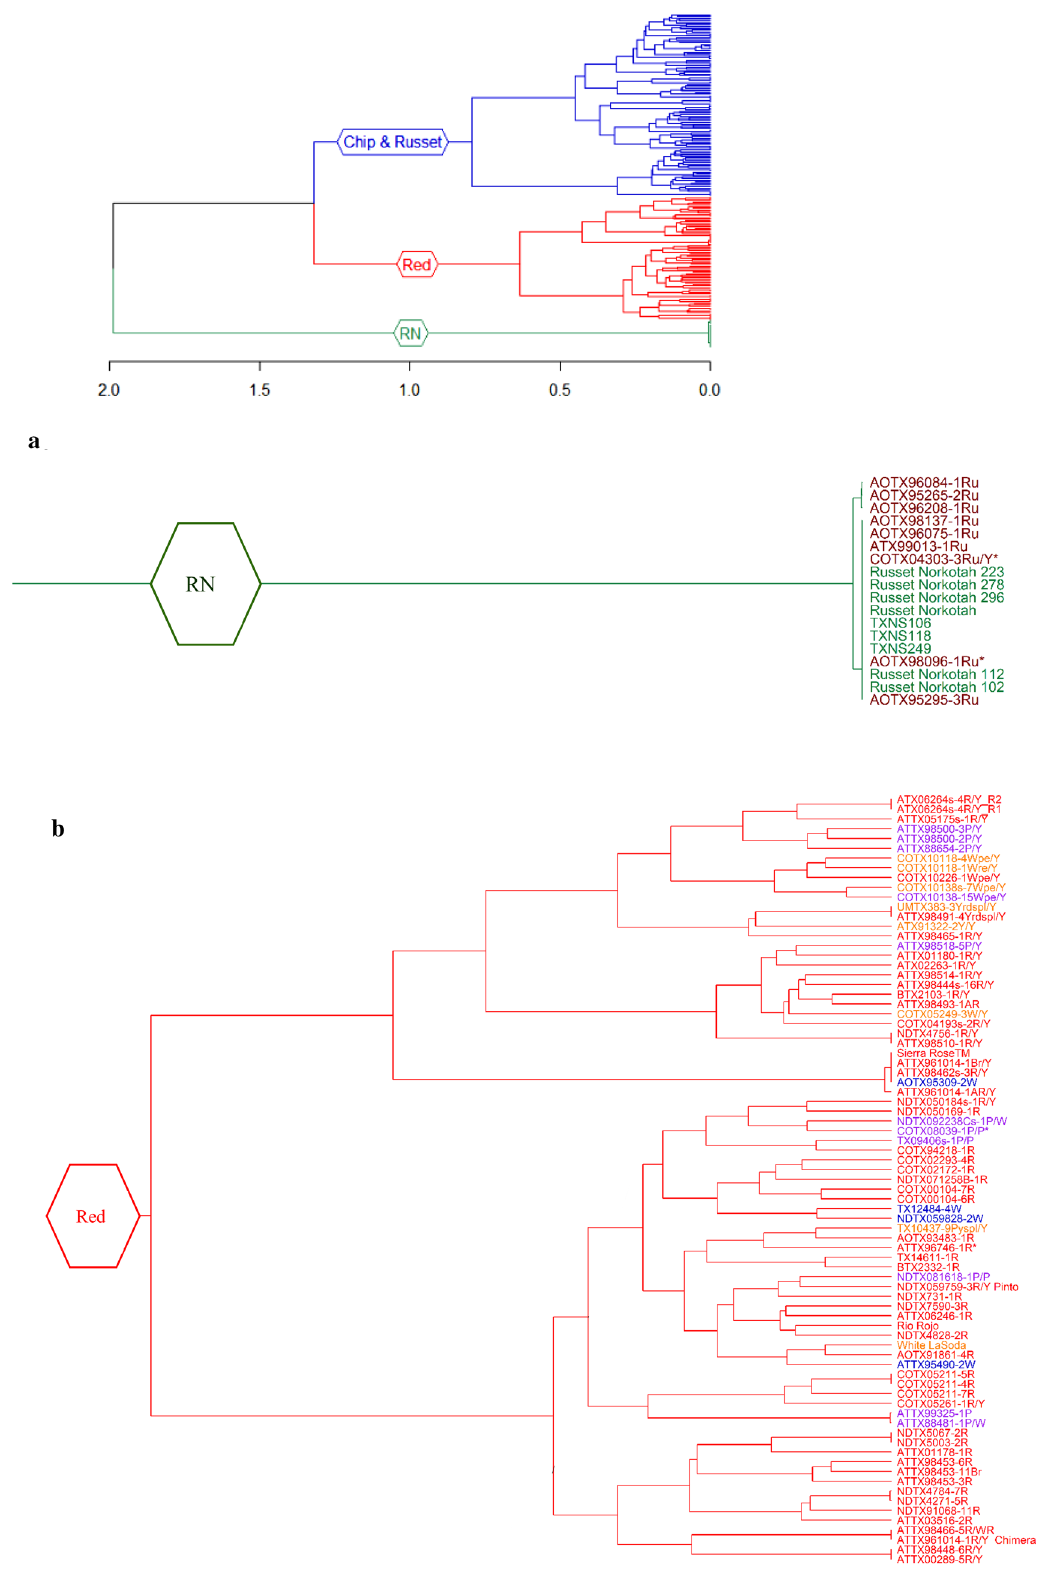
Figure 6. A Ward Dendrogram of the 214 clones using hierarchical clustering (method = “ward D”), the lower part ( a ) representing Russet Norkotah and its strains, the middle part ( b ) representing red and specialties and top part ( c ) representing chipping and russet clones are shown separately. In the X-axis are represented the Nei’s genetic distances between clones. The color of the clones represents the market class (Red = red clones, Purple = purple clones, and Yellow = yellow clones; Green = Russet Clones, and; Blue = chipping clones). Corrected names are indicated by an asterisk sign (*) at the end of the clone name. The plots were constructed using Ape R package 70